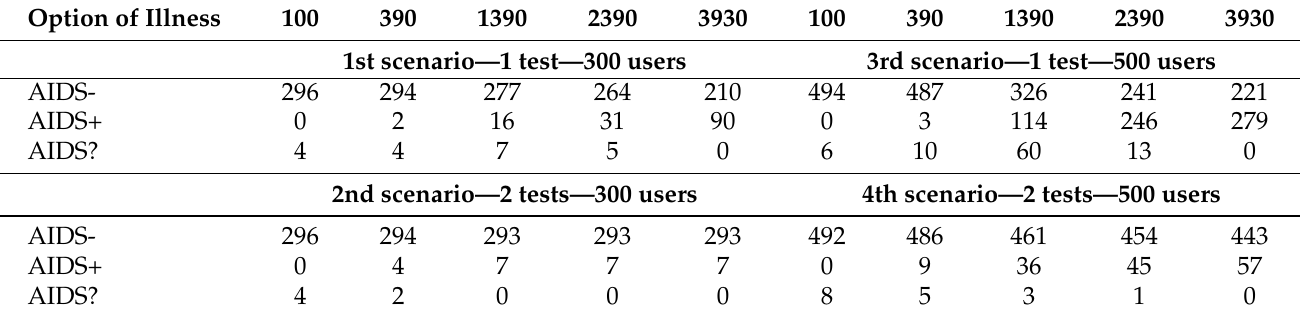
Table 11. Comparison between the four scenarios for a different number of weeks by considering the 12th example with 50%